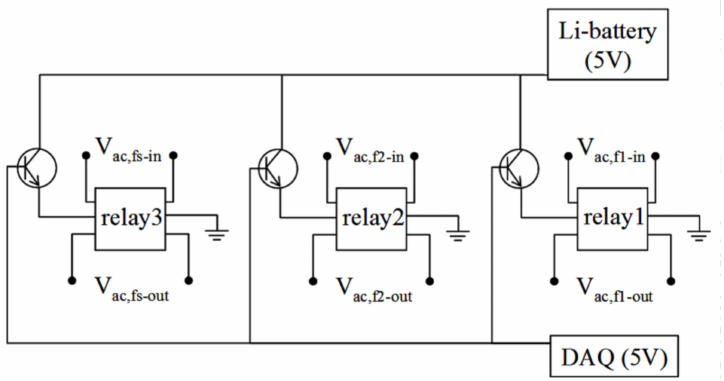
Figure 3. Circuits for electric switches used in the eight-channel AC magnetosusceptometer for